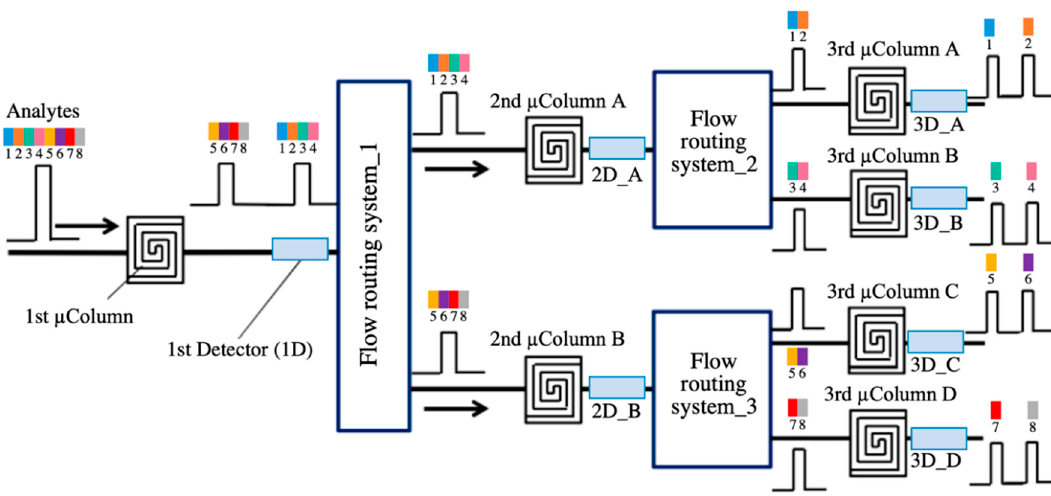
Figure 10. Schematic representation of an automated 3D-µGC system. It consists of a 1 × 2 × 4 channel adaptive configuration with three different levels of separation. The initial vapor mixture consists of eight different VOCs. After each separation column, there is a nondestructive detector connected to a computer-controller flow routing system that directs each vapor peak to the next column [246].